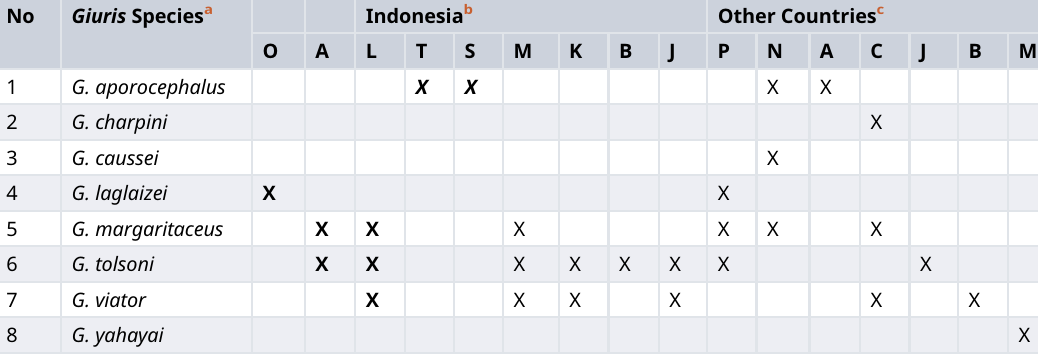
Table 6. Species in the genus Giuris and their known (X) or suspected ( X ) distributions. No Giuris Species